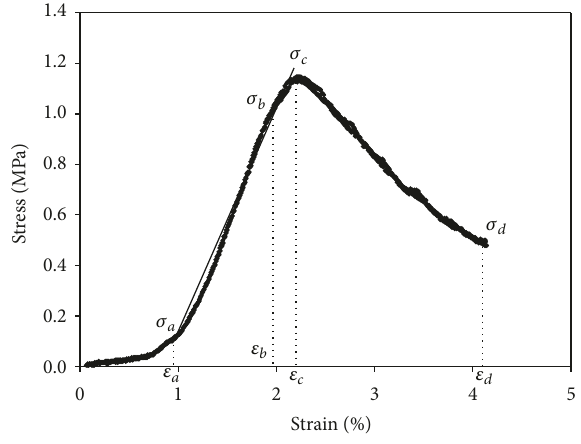
Figure 3: Stress-strain curve of